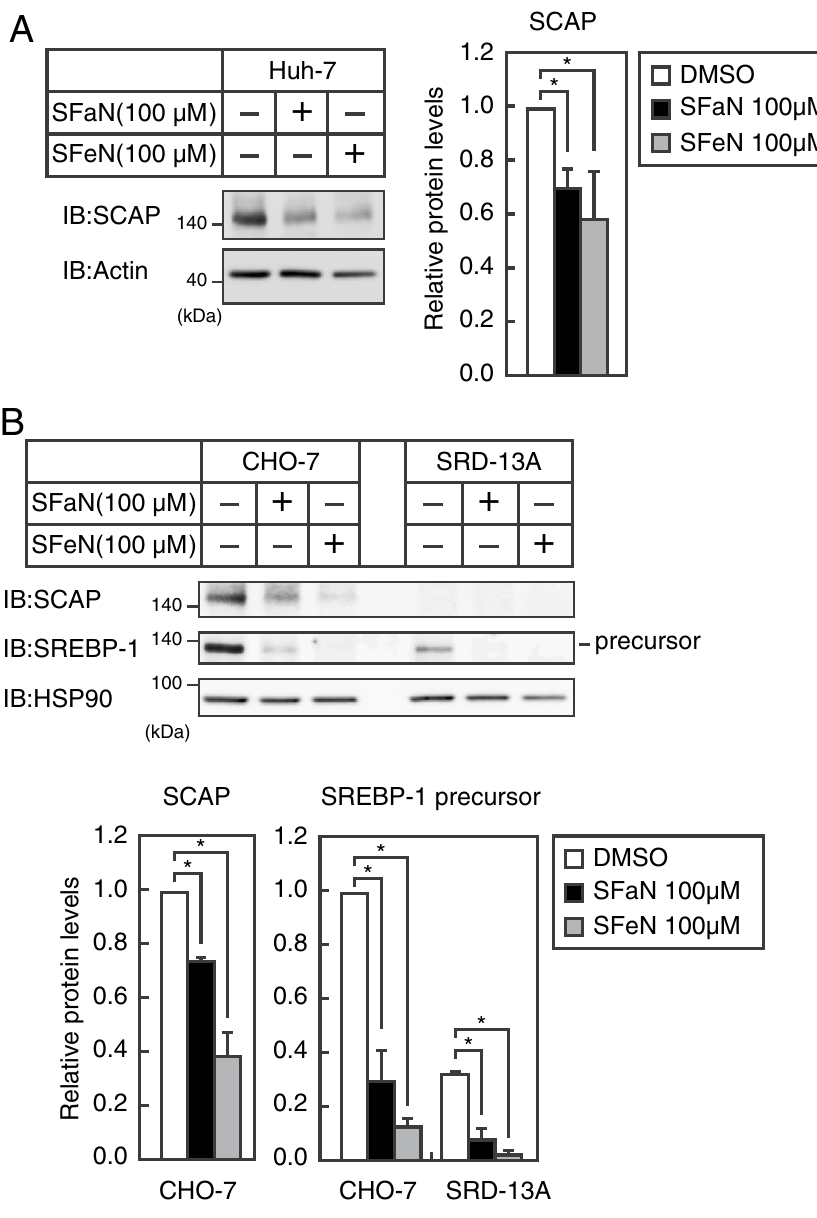
Figure 5. SCAP-independent SREBP precursor form degradation. ( A ) Huh-7 cells were incubated in medium B in the presence of the vehicle, 100 μM SFaN or SFeN for 6 h. Whole-cell extracts underwent immunoblotting (IB) with anti-SCAP or anti-β-actin antibodies. ( B ) CHO-7 and SRD-13A cells were cultured in medium F in the presence of the vehicle, 100 μM SFaN or SFeN for 6 h. Whole-cell extracts underwent immunoblotting (IB) with anti-SCAP, anti-SREBP-1 (2A4), or anti-HSP90 antibodies. The signals (n = 3) were quantified using Image J and normalized to that of β-actin ( A , B ). All data are expressed as means ± S.E. *, p < 0.05. Full-length images of all replicates are presented in Supplementary Fig.